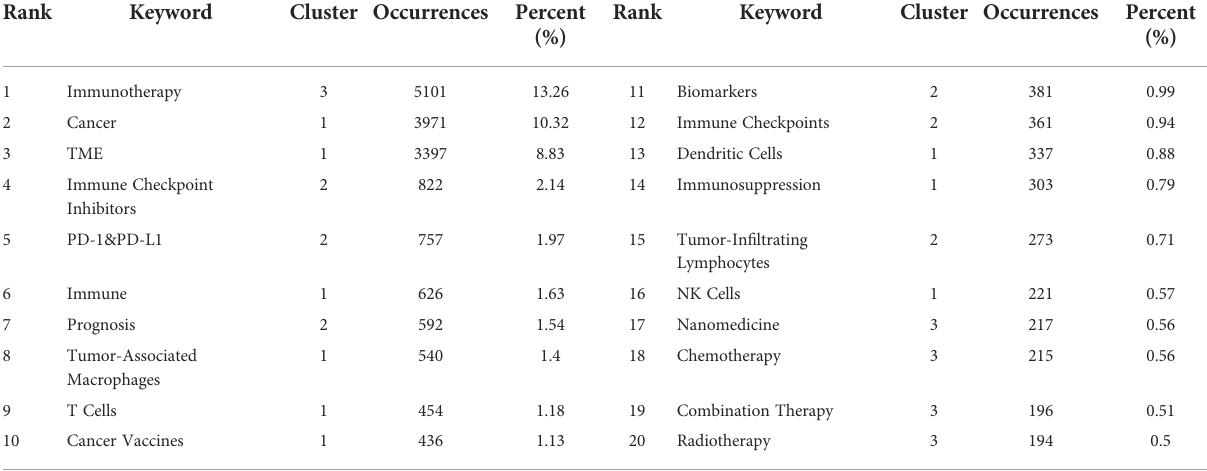
TABLE 5 The top 20 keywords of immunotherapy-TME-related